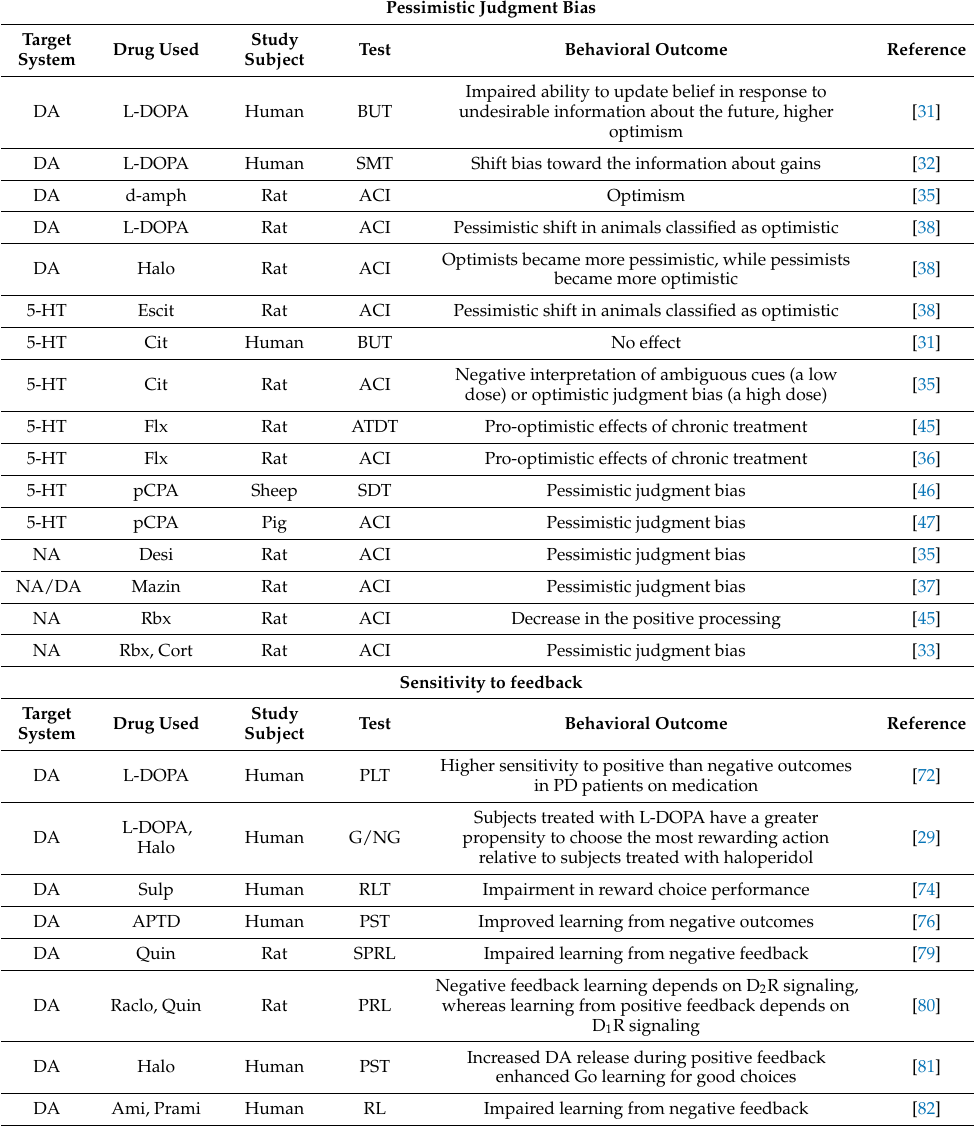
Table 1. Pharmacological manipulations targeting various neurotransmitter systems, which affect pessimistic judgment bias or sensitivity to